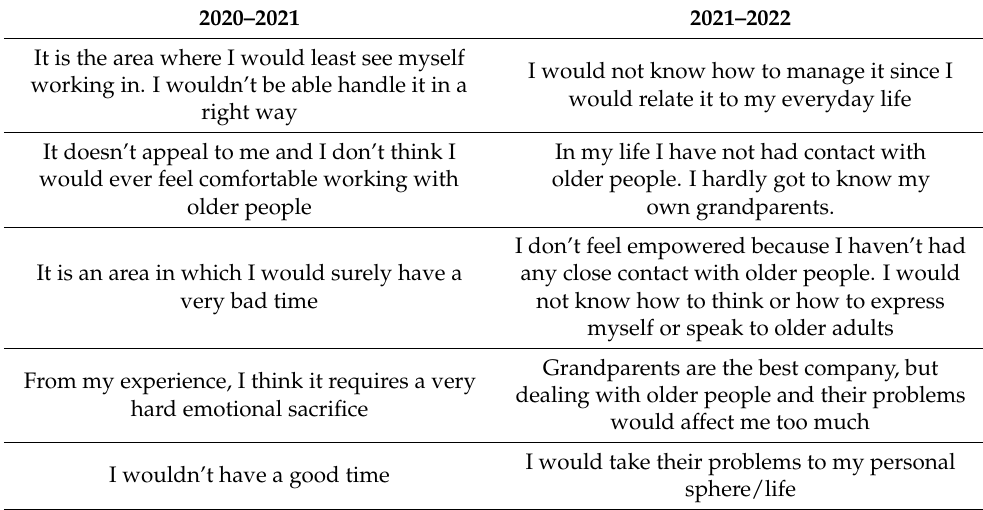
Table 3. Students’ main arguments not to work with older